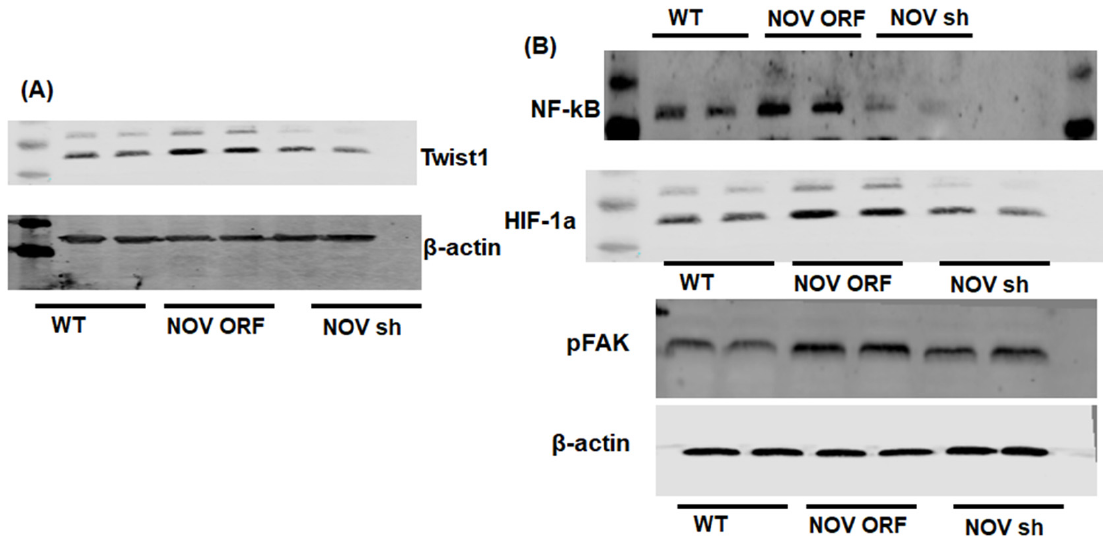
Figure 3. Mitochondrial function and inflammation in adipocytes with the overexpression of NOV (ORF NOV) or NOV knockdown (shNOV) in mice on an HFD. Western blot analysis of Twist Family BHLH Transcription Factor 1 (TWIST1) ( A ), nuclear factor kappa-light-chain-enhancer of activated B cells (NF- ƙ B) ( B ), hypoxia-inducible factor 1-alpha (HIF 1 α ) ( B ), and phosphorylated focal adhe- kinase (pFAK) ( B ). Results are the average of two experiments run in